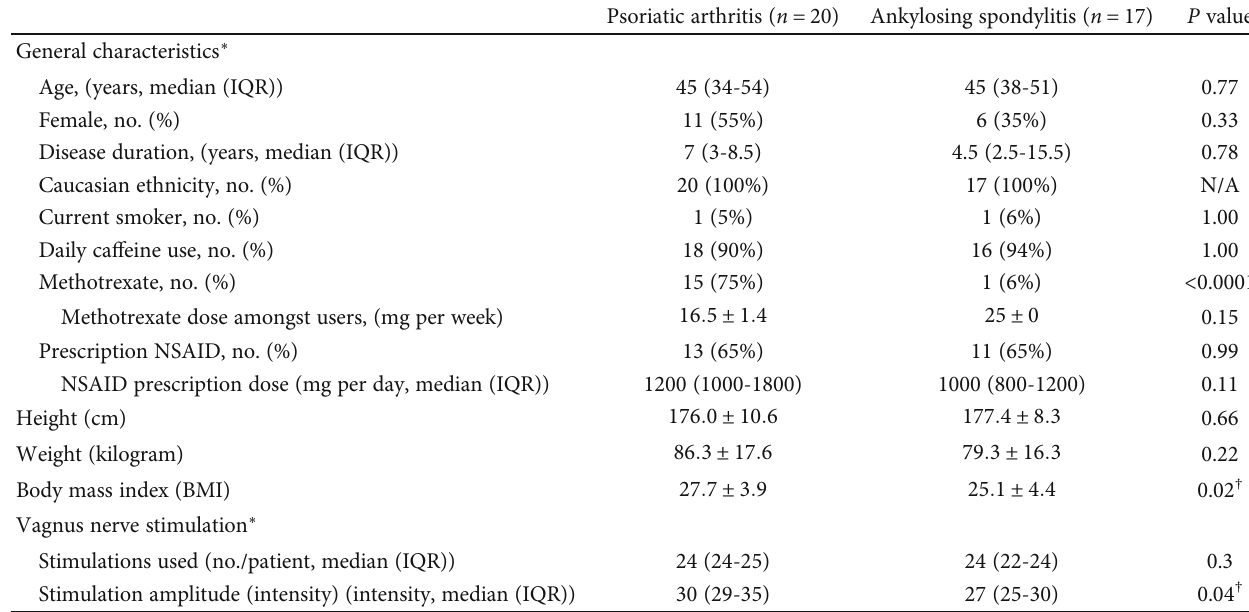
Table 1: Patient characteristics.